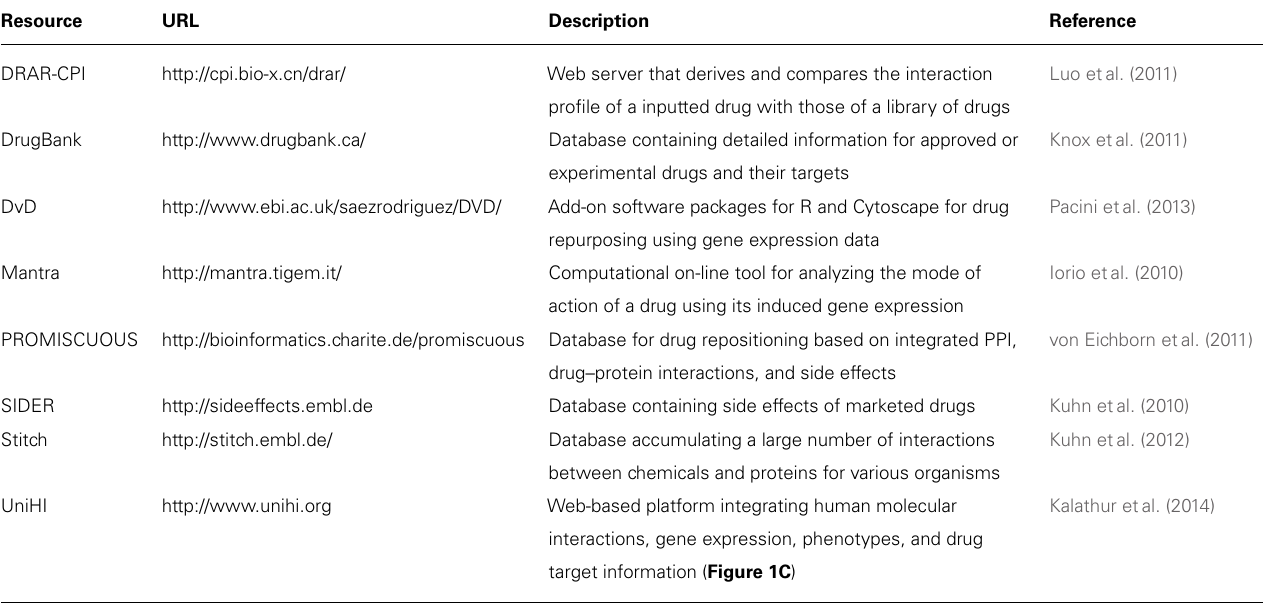
Table 1 | Publically available resource for network-based drug targeting and repositioning. Resource